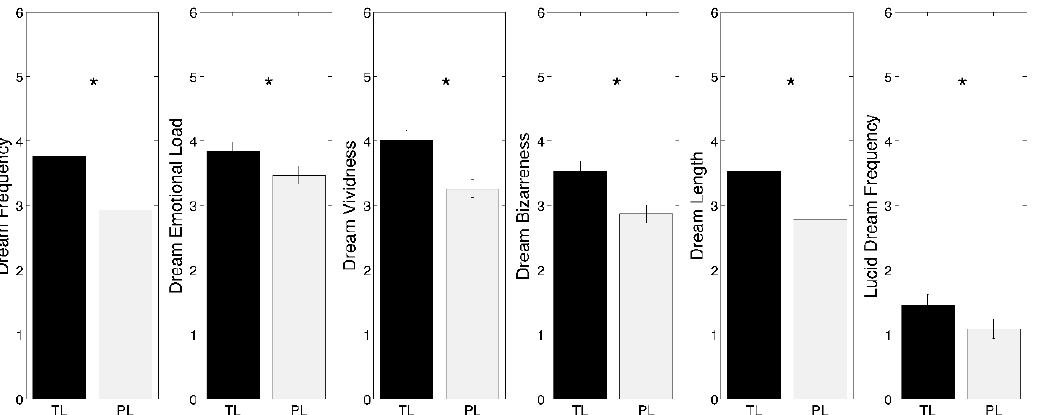
Figure 1. Results of the comparisons (paired t -tests) between total lockdown (TL, black bars) and